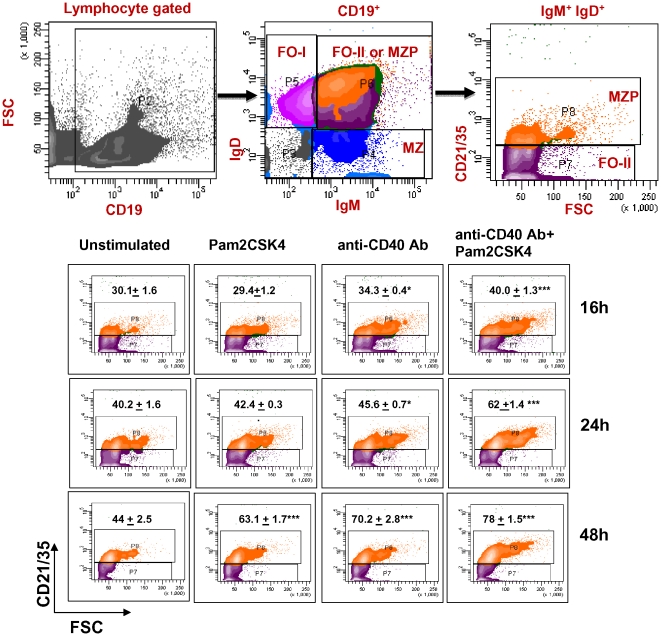
Signaling through TLR2.CD40 differentiates RB cells into marginal zone precursors.Signaling was delivered in RB cells with Pam2CSK4 and anti-CD40 Ab for 16 h–48 h. Upper panel shows the gating scheme for defining different B cell subsets: FO-I (CD19+ IgDhi), FO-II (CD19+ IgDhi IgMhi), MZP (CD19+ IgMhi IgDhi CD21/35hi) and MZ (CD19+ IgMhi). Lower panel shows contour diagrams of MZP in stimulated B cells at different time durations. Values indicate the average change (mean ± SEM) in percent population of CD21/35hi expressing B cells. Contours represent one of the three independent experiments. ‘*’, ‘**’, ‘***’ indicates p<0.05, p<0.01, p<0.001 respectively.